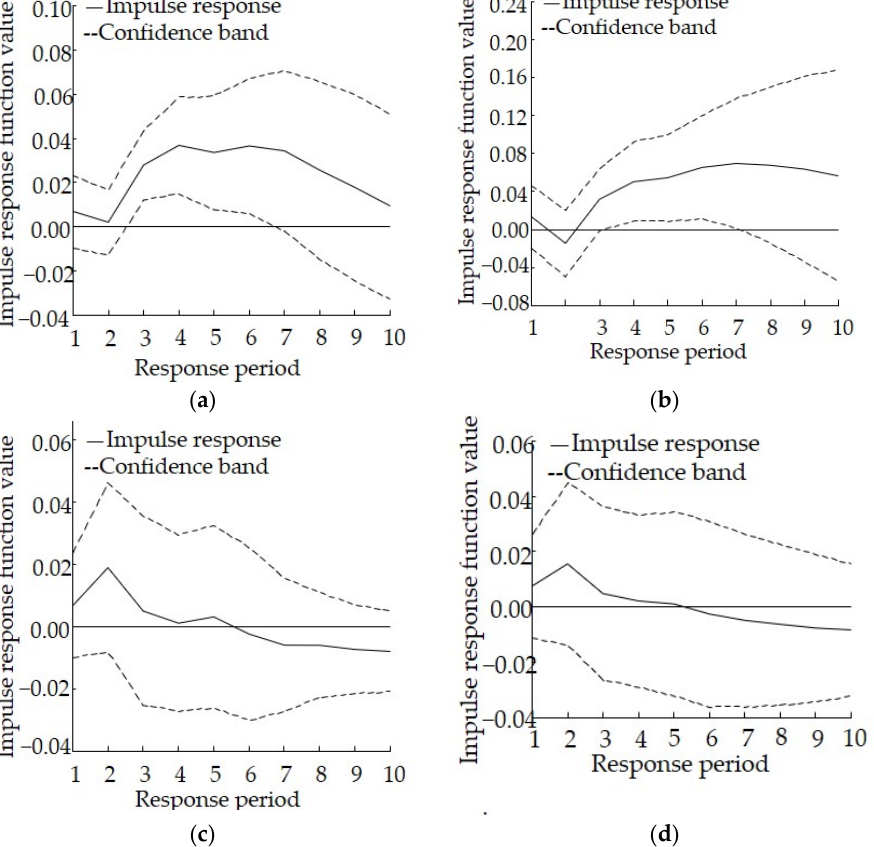
Figure 4. Impulse response relationship between industrial structure adjustment and the discharge of pollutants to the aquatic environment in Qinghai, ( a ) Impulse response of lnCOD to lnSI, ( b ) Impulse response of lnAN to lnSI, ( c ) Impulse response of lnSI to lnCOD, ( d ) Impulse response of lnSI to lnAN. Table 6. Forecast variance decomposition of the discharge of pollutants to the aquatic environment in response to industrial structure adjustment in